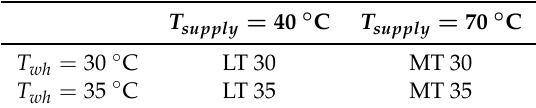
Table 3. The four simulated cases, corresponding to the two different supply temperature alternatives ( T supply ) and two waste heat temperatures ( T wh